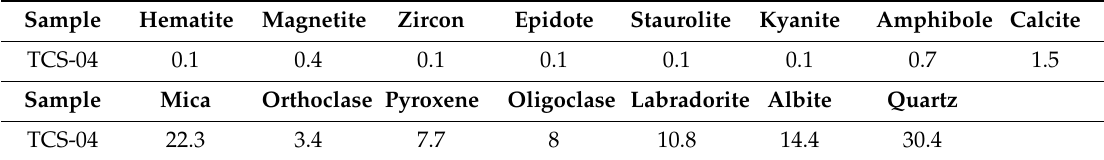
Table 4. Mineral analysis (%) of uranium ore by